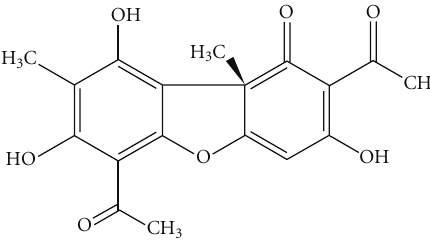
Figure 1: Molecular structure of usnic